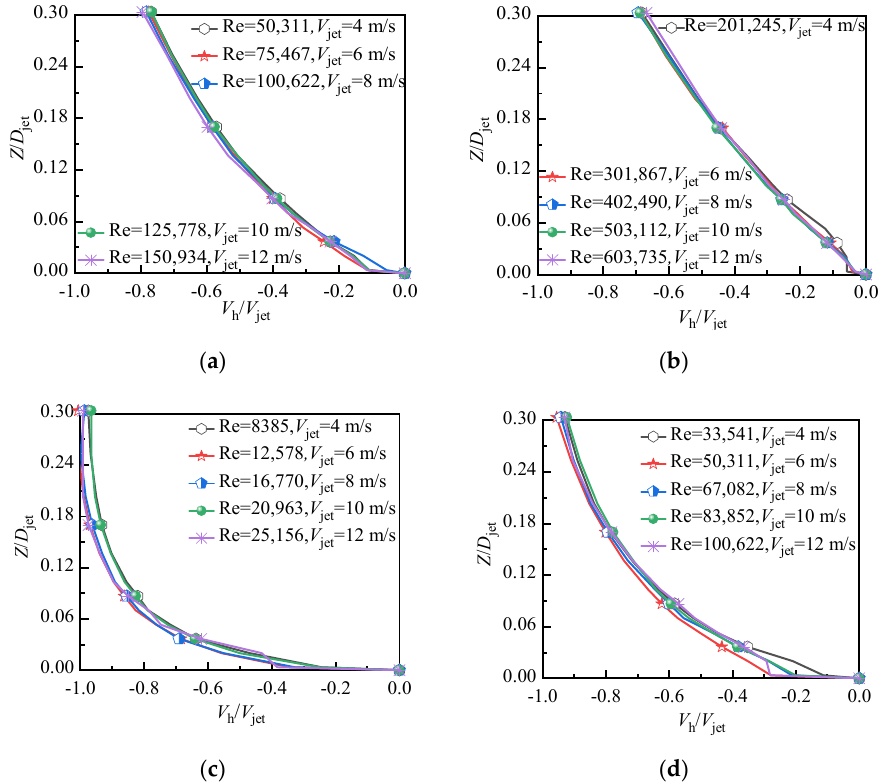
Figure 6. Profiles of vertical velocity: ( a ) H1, crest; ( b ) H7, crest; ( c ) H6, crest; ( d ) H12, crest. Table 3. Reynolds numbers for hill models ( V jet = 12 m/s).